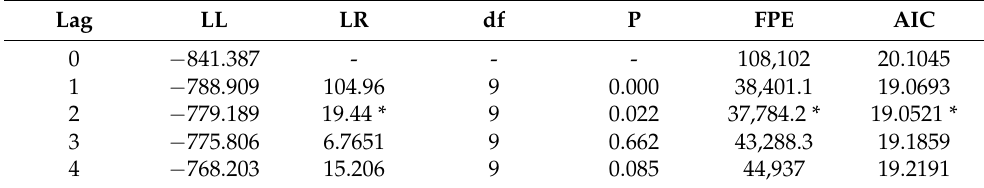
Figure 6. Response of electricity consumption of the industry sector to space weather . Table 7 shows the AIC information concerning power station revenue. The optimal lag length is two, as an AIC lag length of three is the minimum, and the data pass the balance test, as all of the dots are in the circle, which is shown in Figure 7. Table 7. Optimal lag length concerning the power station revenue.